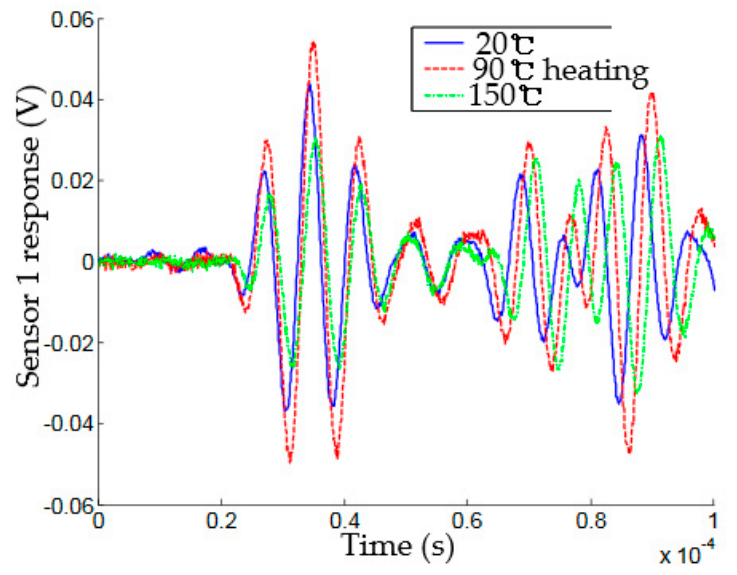
Figure 12. Temperature effect on PZT amplitude